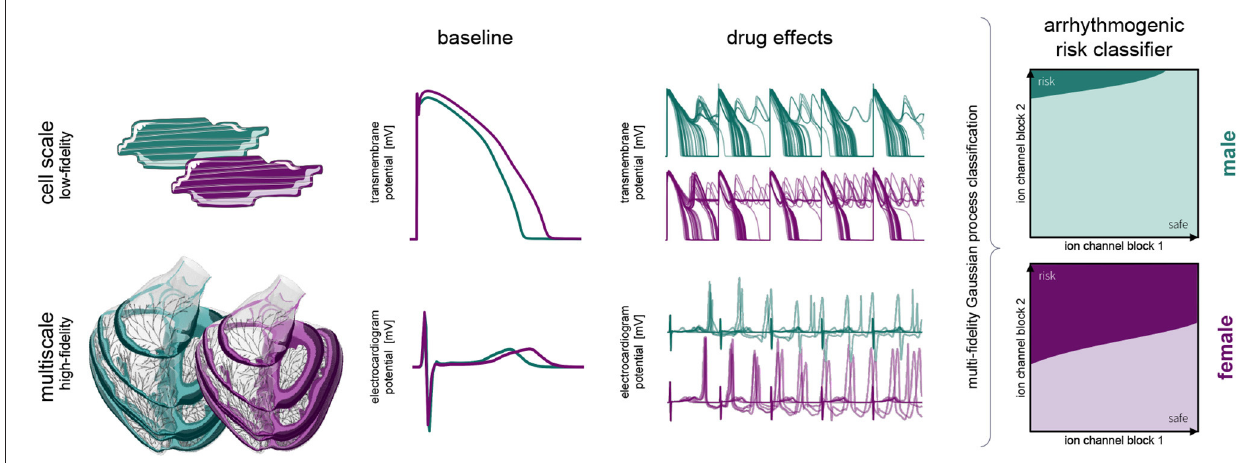
FIGURE 1 | Sex differences in drug-induced arrhythmogenesis: a combined multiscale modeling and machine learning approach . We develop individual male and female low-fidelity cell and high-fidelity multiscale exposure-response simulators. These simulators take into account differences in subcellular ion channel activity between men and women for the low-fidelity exposure-response proxy. The high-fidelity model also takes into account sex differences tissue-level conductivity and organ-scale geometry. We perform an arrhythmic sensitivity study of the male and female heart to drug-specific ion channel blocking and susbsequently combine low-fidelity cell-scale and high-fidelity multiscale modeling to delineate arrhythmogenic risk classification boundaries for men and women.